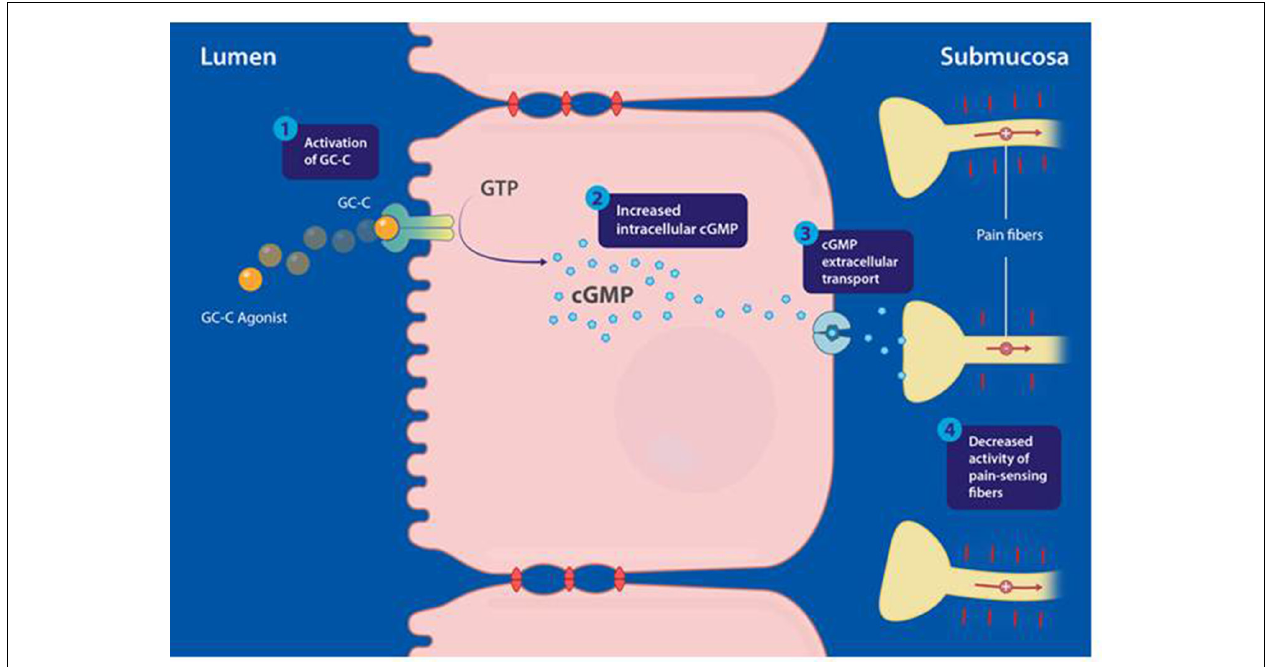
inside intestinal epithelial cells. (3) Intracellular cGMP is actively transported out of intestinal epithelial cells by efflux pumps into the submucosa. (4) Extracellular cGMP is proposed to inhibit colonic nociceptors. Adapted from Silos-Santiago etal. (2013); the figure has been reproduced with permission of the International Association for the Study of Pain ®